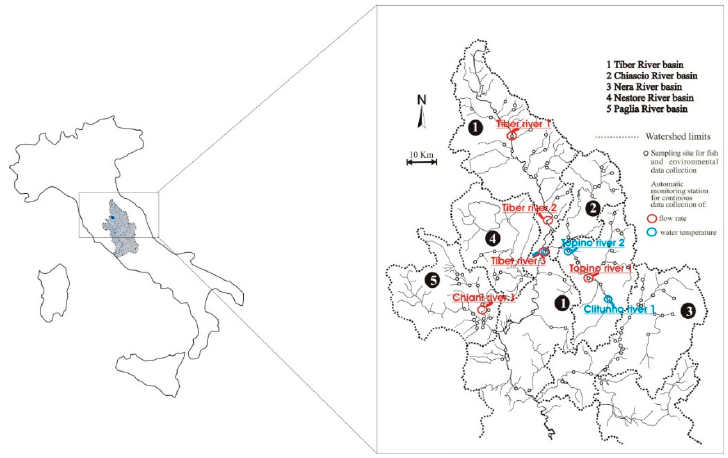
Figure 1. Study area and location of the sampling sites.